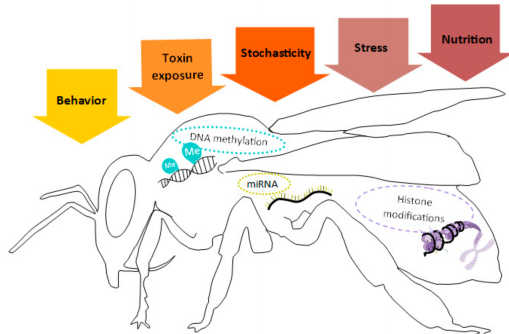
Figure 4. Environmental factors that trigger epigenetic mechanisms: Schematic representation of an insect (represented by a bee silhouette) illustrating the main EMMs found. The colored arrows denote the five main environmental factors that have been described in the literature that trigger the different epigenetic responses in the organism. These responses may be pre-transcriptional such as DNAm and histone modifications, or post-transcriptional such as miRNA interference. Figure by Gabriela Olivares-Castro